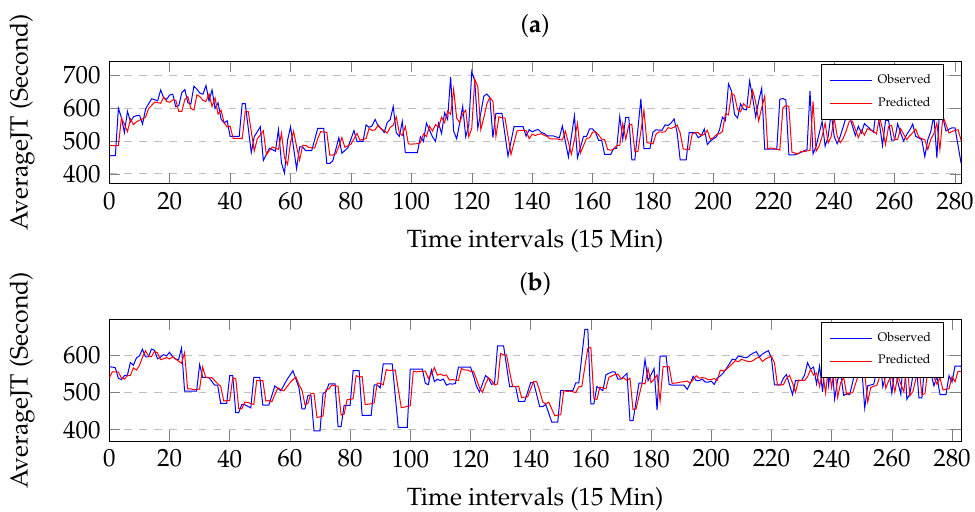
Figure 6. Effectiveness of the prediction under the different traffic conditions. The horizontal axis is time interval and the vertical axis is travel-time. ( a ) Comparison between the observed values and the predicted values on Link AL282. ( b ) Comparison between the observed values and the predicted values on Link AL281.